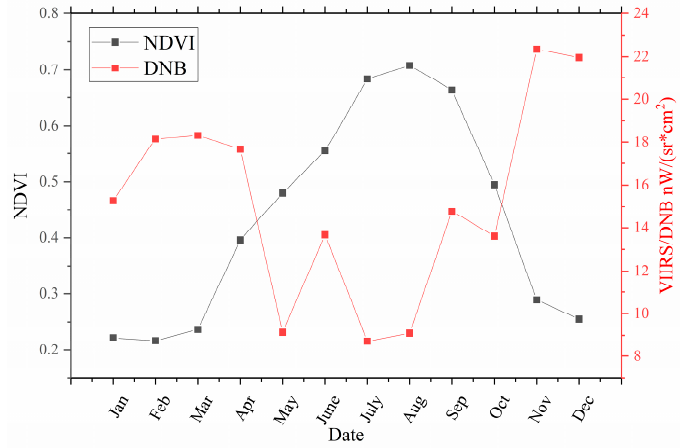
Figure 11. Monthly variations of NDVI and VIIRS/DNB radiance in BTH 2021.